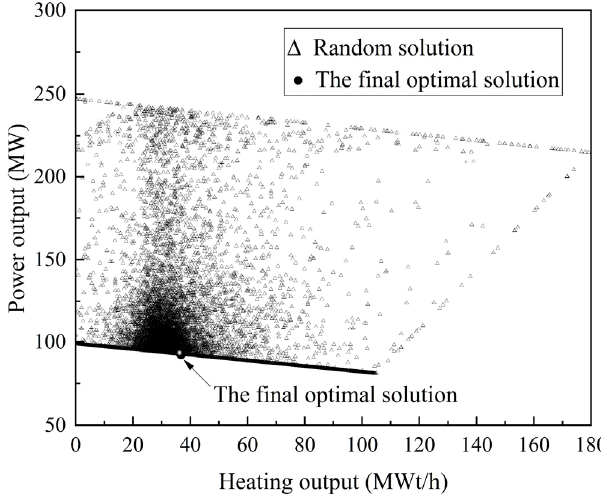
Figure 5. The individual optimization trace of cogeneration unit 5 with GWO